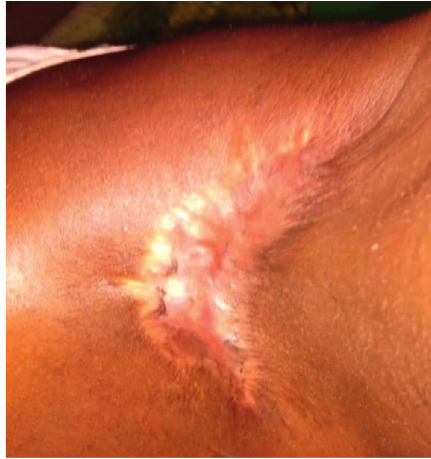
Figure 6: Postchemotherapy and radiotherapy aspect showing total regression of neck mass, fracture, and wound